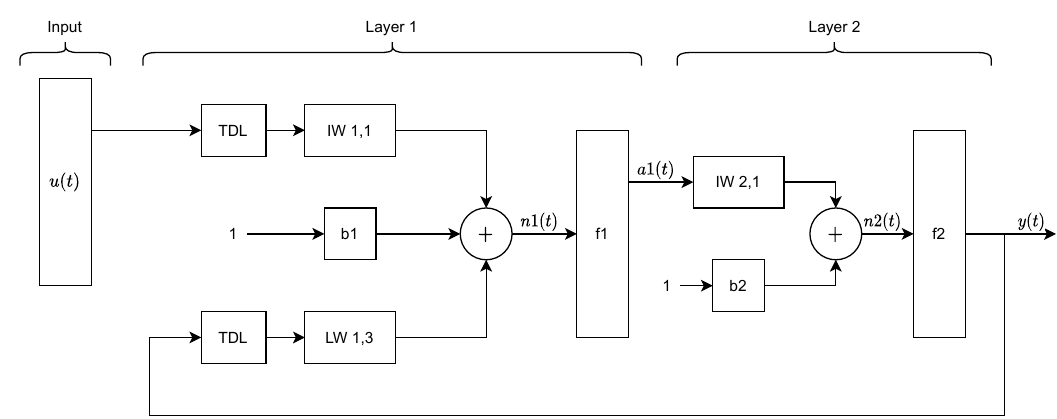
Figure 4. Representation of neural network (NN)-nonlinear autoregressive neural network with external inputs (NARX) structure. The first layer activation function f 1 is generally a nonlinear activation function to model nonlinear relations in the data. The second layer activation function f 2 is a linear activation function that rescales NARX output to original output data. Thus, it can yield satisfactory predictions of a nonlinear system